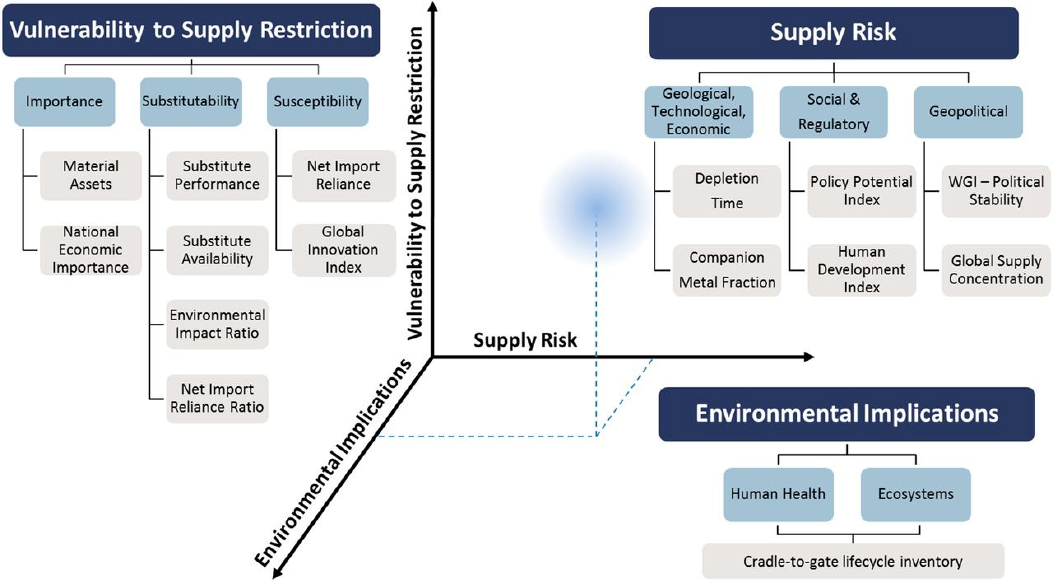
Figure 16. The methodology of criticality, showing the importance of substitution in the vertical axis (see [260]).